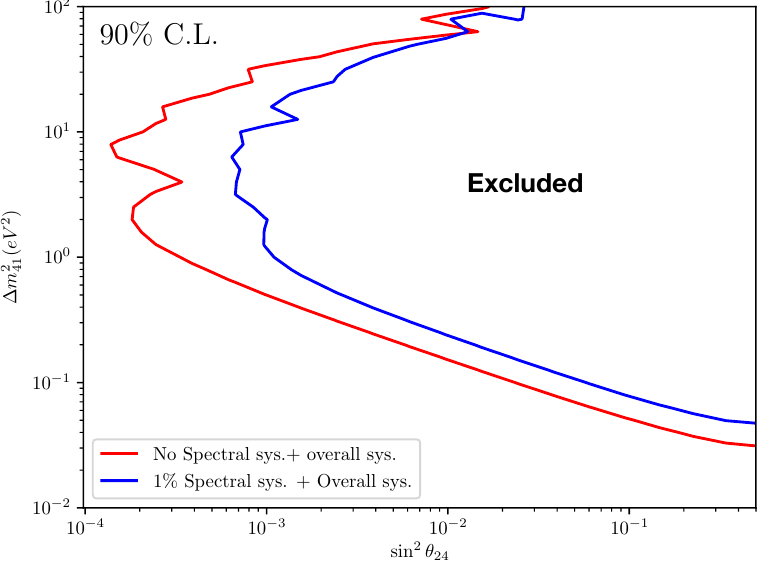
Figure 161. The 90 % CL DUNE ND-only θ 24 exclusion regions when including normalization systematics, but no spectral shape systematics (red curve), and when including normalization and shape systematics. Both curves were computed using the GLoBES toolkit assuming a 3+1 model with one sterile neutrino. For reference, the projected DUNE limits significantly exceed the current limits from MINOS [261] and IceCube [262] over much of the ∆ m 2 41